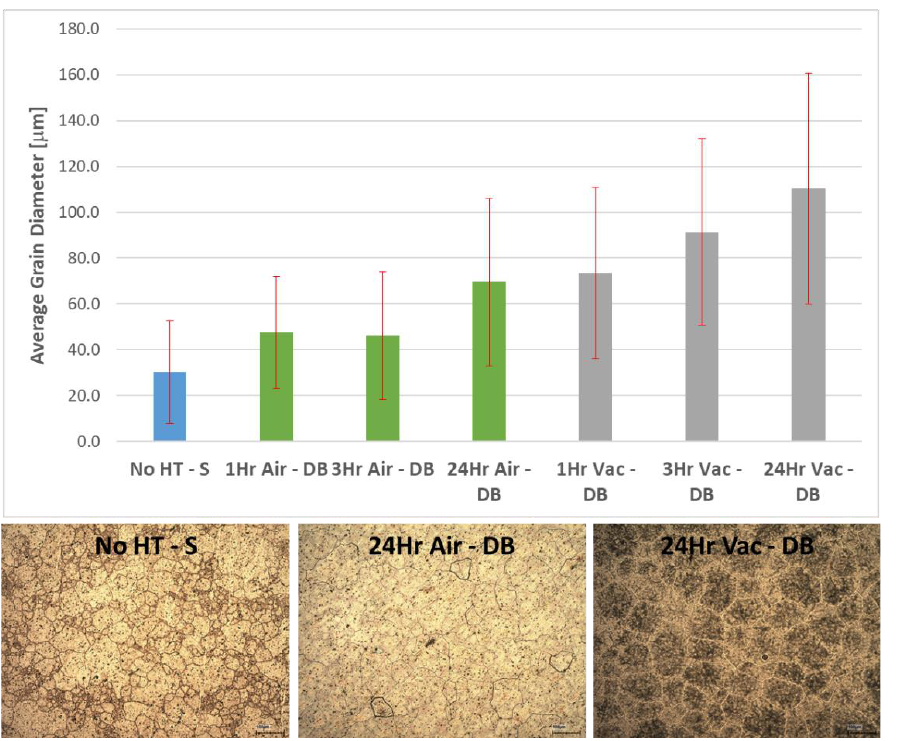
Figure A2. AA1050 average grain size distribution results before and after DB processes.